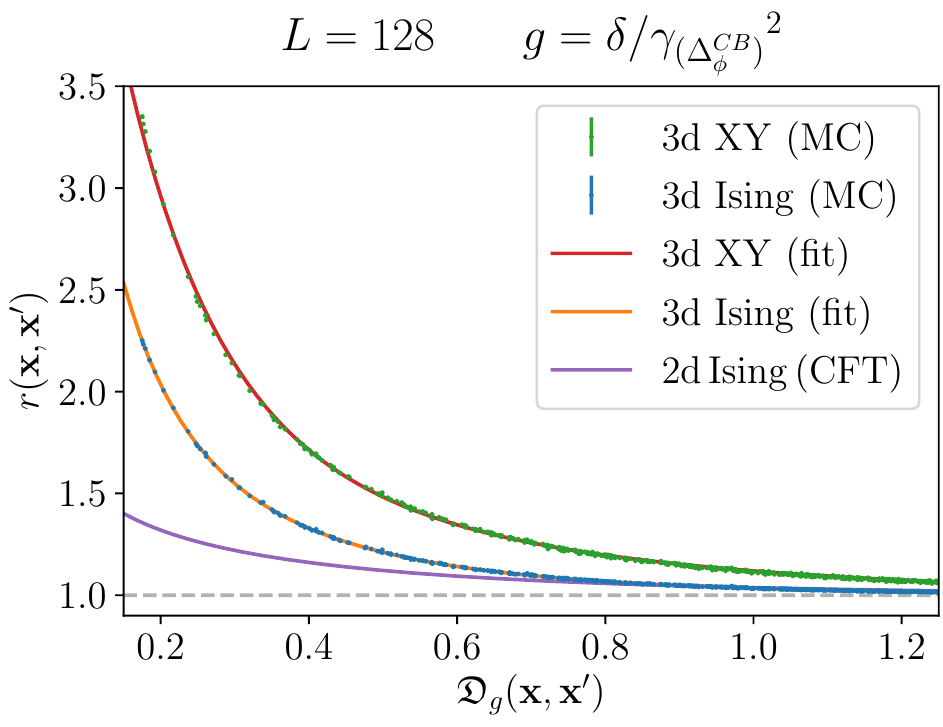
Figure 4 . Correlation ratio of the 3 d Ising and clock models, each computed as a function of the respective fractional Yamabe distance. The lines shown under the numerical data are fitting functions. The exact function is shown also for the Ising 2 d as obtained exactly from